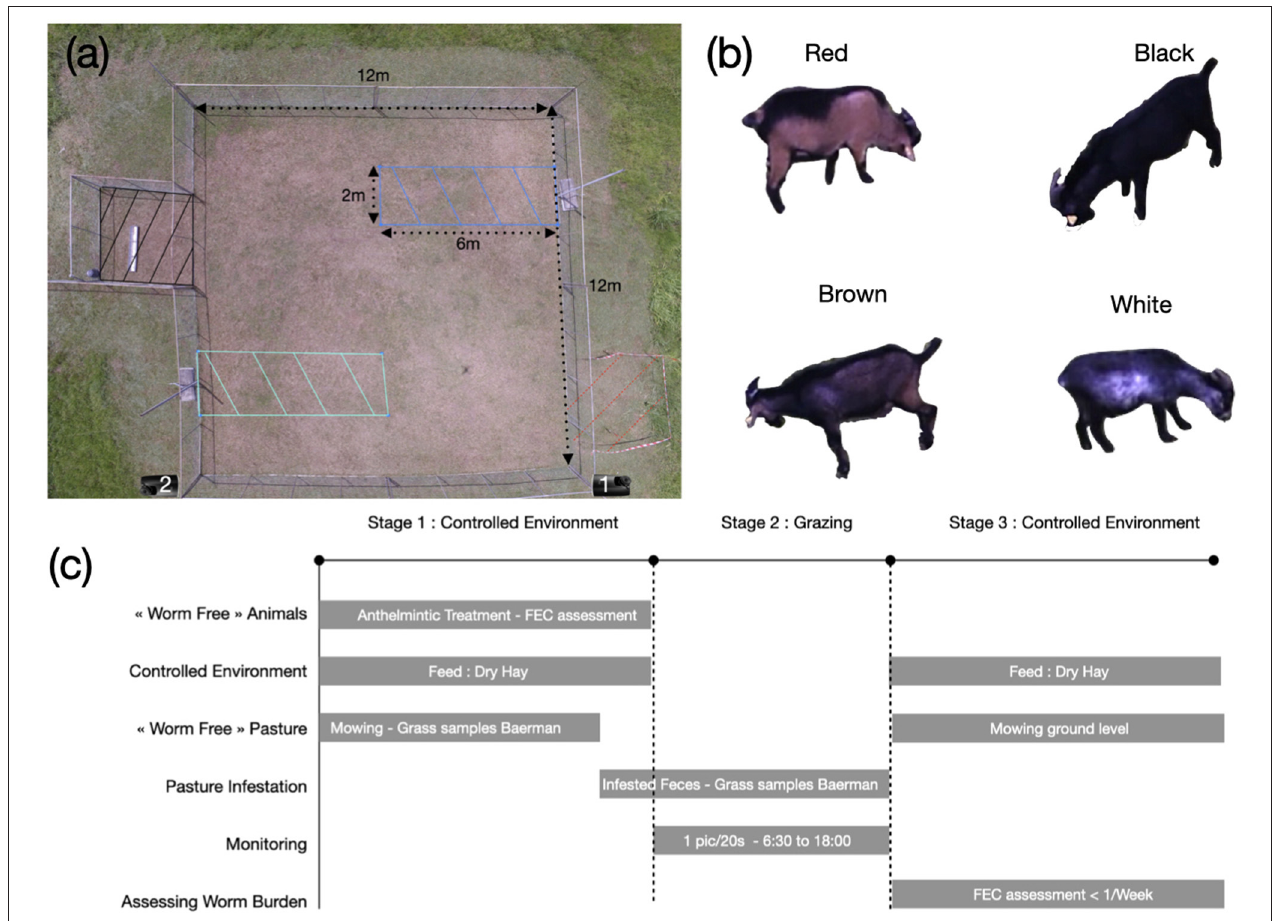
FIGURE 1 | (a) Pasture setup. The green and blue dashed zones are the infested areas A and B. The black dashed square is the resting area. During experiment, we placed a sheet of metal inside the area to produce shade. The red area is the control area, to estimate the number of infected larvae on pasture. During week 2, the control area was located on the opposite side of pasture (not displayed here). On week 1, we used the camera located on the bottom right corner of the pasture and on the bottom left on week 2. (b) Picture example of the four Creole goats used during the experiment. (c) Schematic representation of the